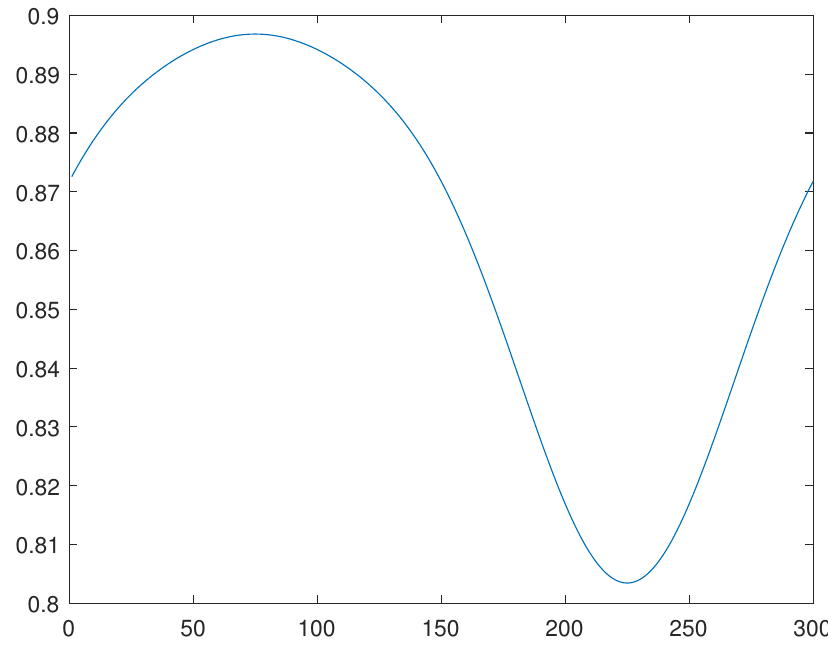
Figure 3. Line 2, solution u 2 ( x ) through the minimization of functional J .